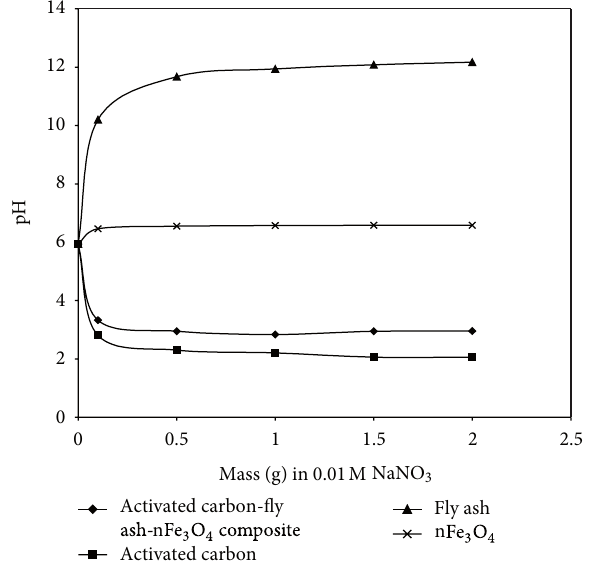
F 18: Result of mass titration experiments with activated and activated carbon-�y ash-nSiO composite carbon, �y ash, nSiO material. Variation of pH versus mass of solid in 0.01M NaNO 3 2 2